Question: Condense the content of this figure into a single sentence.
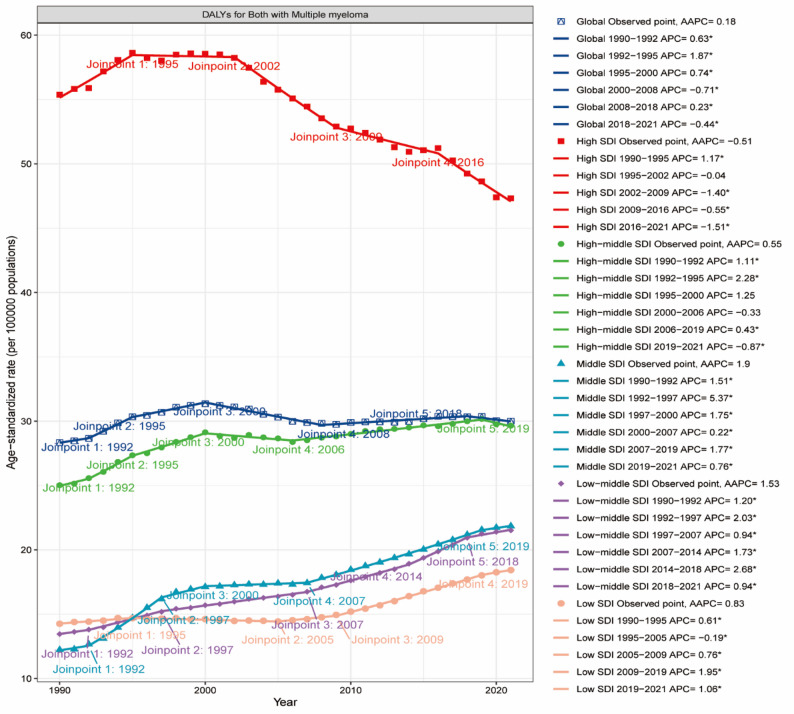
Answer: Temporal trends in AS-DALYsR for MM on a global scale and within diverse SDI regions (1990–2021)